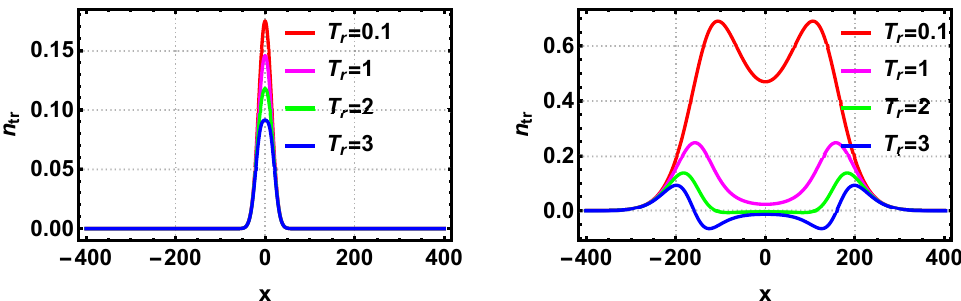
Figure 11. The characteristics of trapped ion density n tr for different T r is shown keeping ψ and δ constant. The left panel shows the case for different T r keeping ψ = 0.01 and δ = 10 as fixed, i.e., from Region 1. The right panel show the case for different T r keeping ψ = 3 and δ = 40 as constants, i.e., from Region